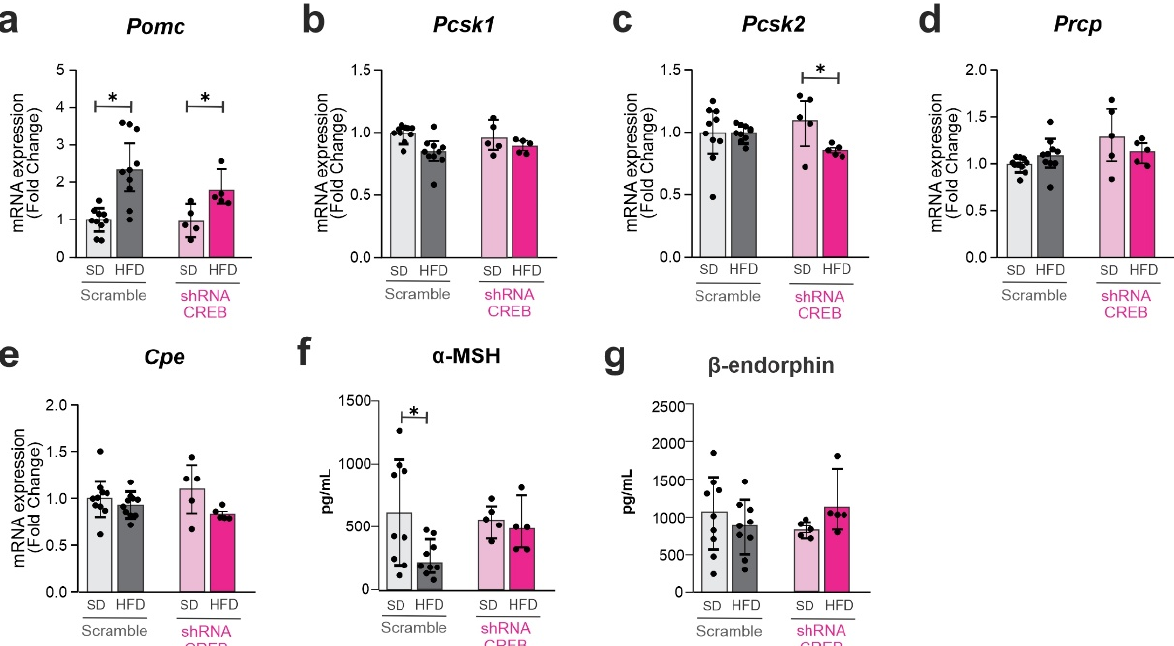
Figure 7. The impact of hypothalamic CREB on Pomc cleavage enzymes upon short-term HFD. Adult male C57BL/6J mice were submitted to a bilateral injection of lentivirus particles (Scramble or shRNA CREB) into the arcuate nucleus (ARC) and, after 10 days, were fed an SD or HFD for 3 days. Hypothalamus and blood were collected at day 15 after surgery. ( a – e ) Hypothalamic mRNA expression of Pomc and Pomc-related processing enzymes; ( f , g ) serum levels of Pomc peptide prod- ucts. Data are presented as means ± SD. N = 5–15 mice in two different cohorts. Two-way ANOVA followed by Sidak’s post hoc test was used for statistical analyses. * p ≤ 0.05 in comparison with groups indicated in the figure.